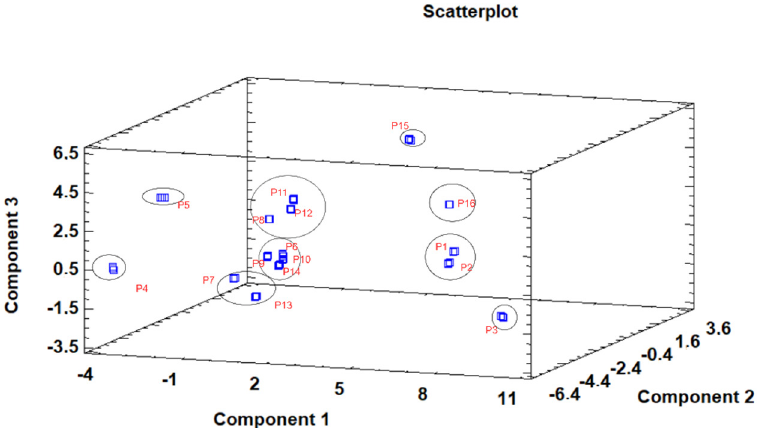
Figure 3. Three − dimensional principal component scatterplot of the tested variables at different maturation stages of cardoon petioles (samples P 1–16).